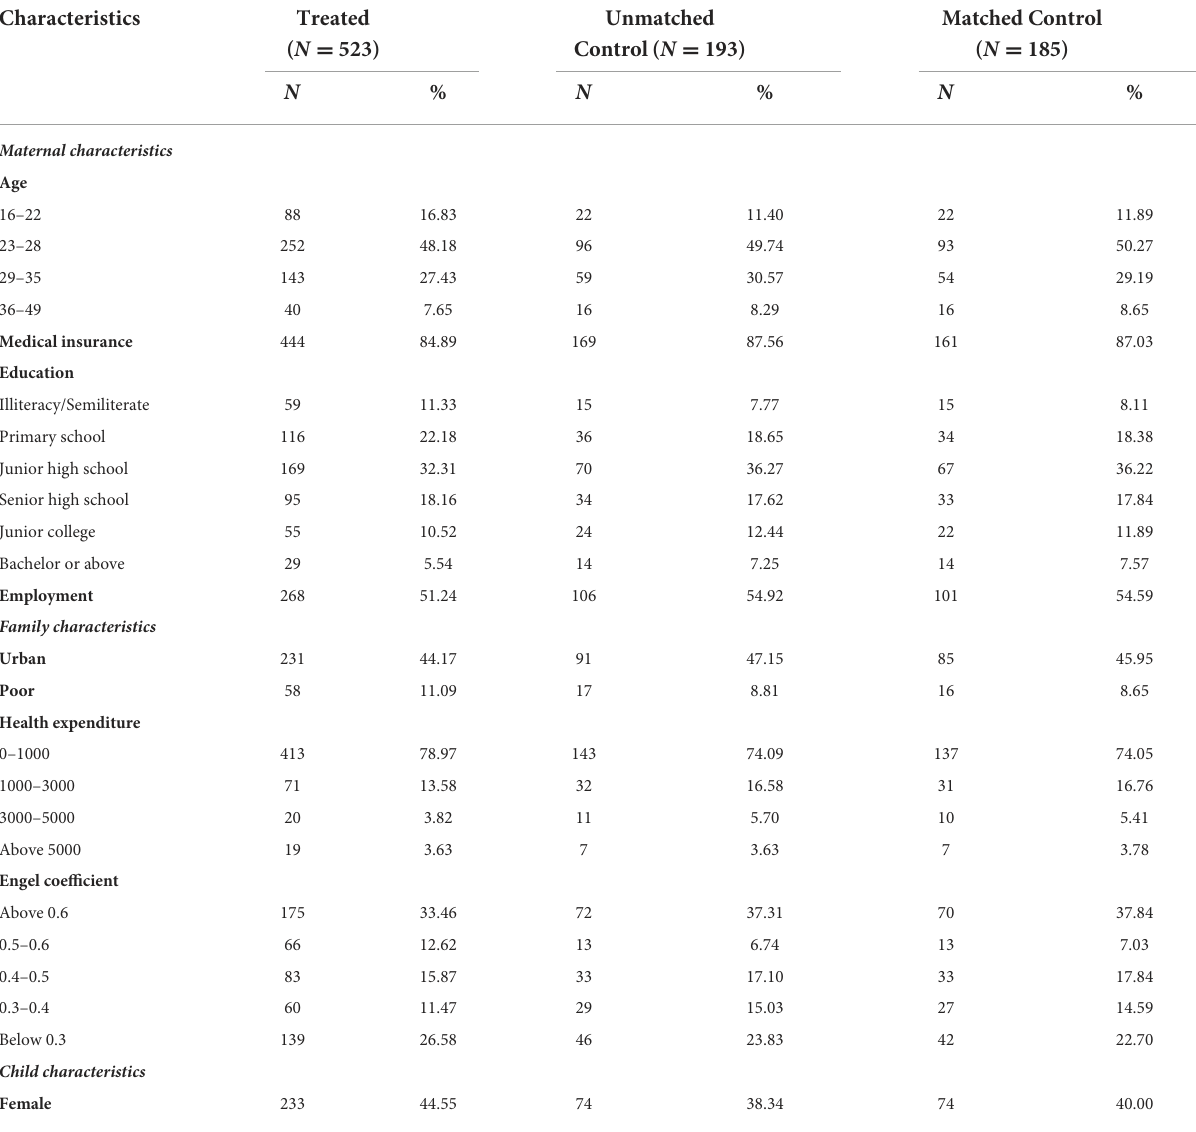
TABLE 3 Descriptive statistics of the covariates for study samples in the intertemporal group.